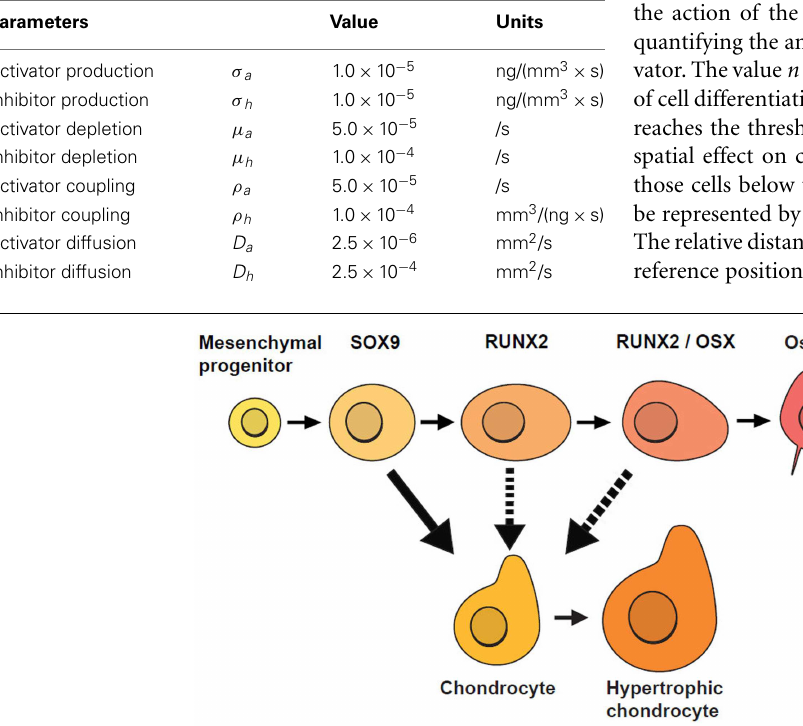
FIGURE 4 | Stages of osteoblast lineage cell (OLC) differentiation . Mesenchymal progenitors give rise to osteoblasts and chondrocytes and are usually marked by SOX9. If SOX9 + cells do not differentiate into chondrocytes, they progress along an osteogenic path and as they mature,